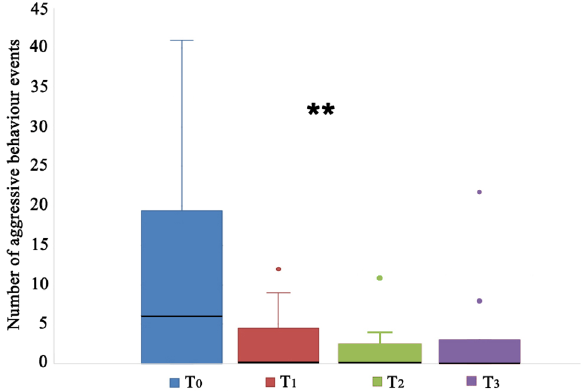
Figure 1. Aggressive behaviour towards humans of dogs treated with cannabidiol (CBD) at the start of the study (T 0 ), after 15 (T 1 ) and 45 (T 2 ) days from the beginning of the treatment, and 15 days after the end of the administration of CBD (T